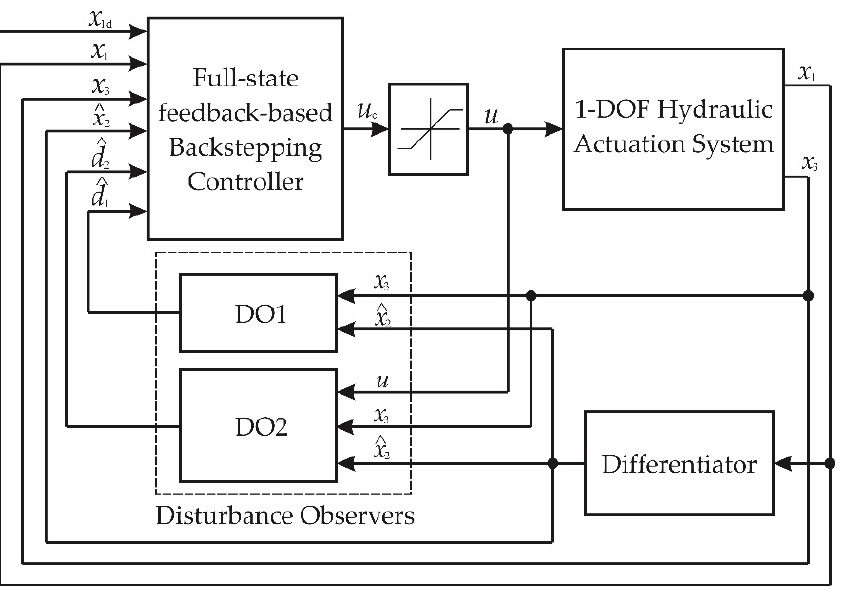
Figure 2. The proposed control system based on disturbance observers with backstepping control.